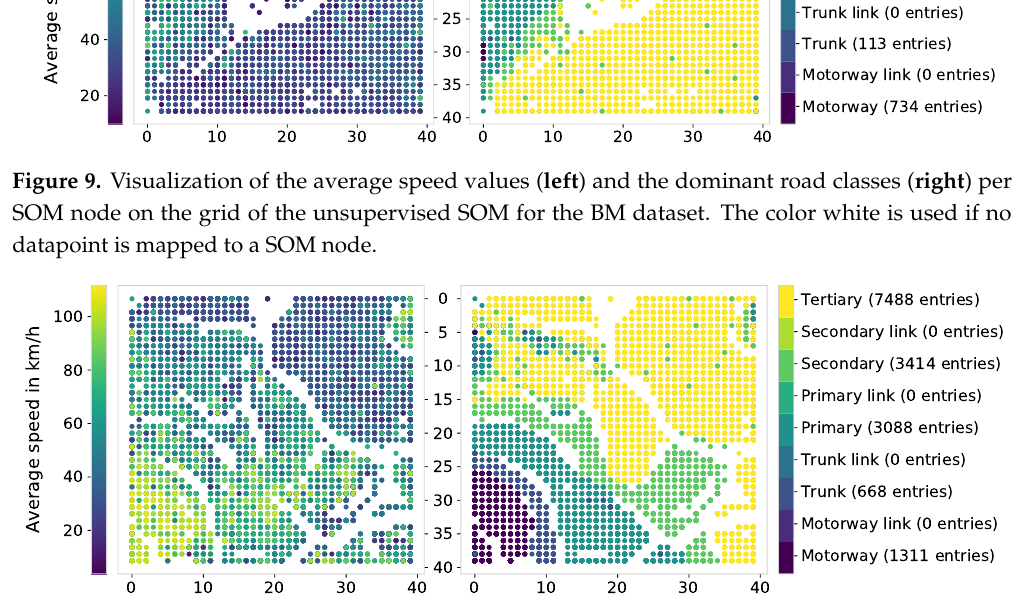
Figure 10. Visualization of the average speed values ( left ) and the dominant road classes ( right ) per SOM node on the grid of the unsupervised SOM for the combined dataset. The color white is used if no datapoint is mapped to a SOM